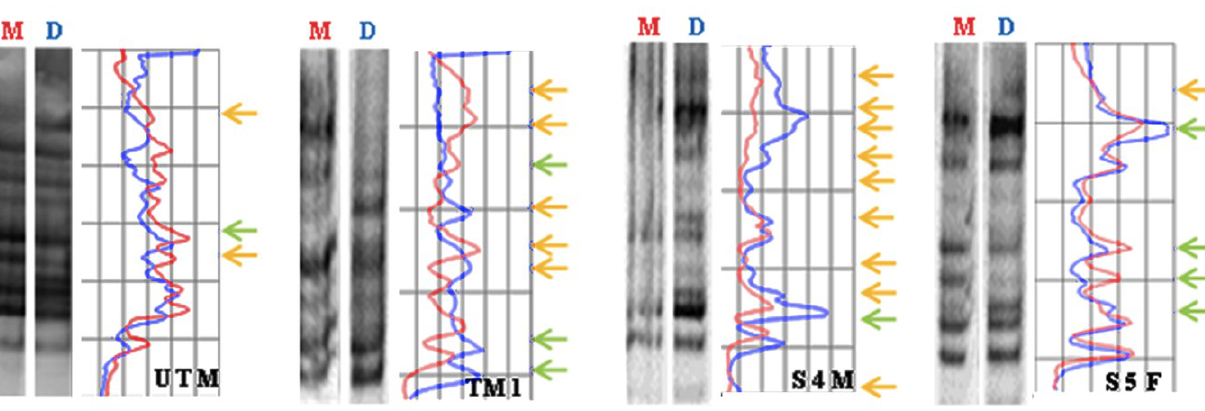
Figure 3. Methylation sensitive Arbitrarily Primed PCR of four representative samples. UTM = Untreated Male; TM1 = Early life treated mother; S4M = Male F1 Offspring; S5F = Female F1 Offspring. M= Mono-digested DNA; D= Double-digested DNA.